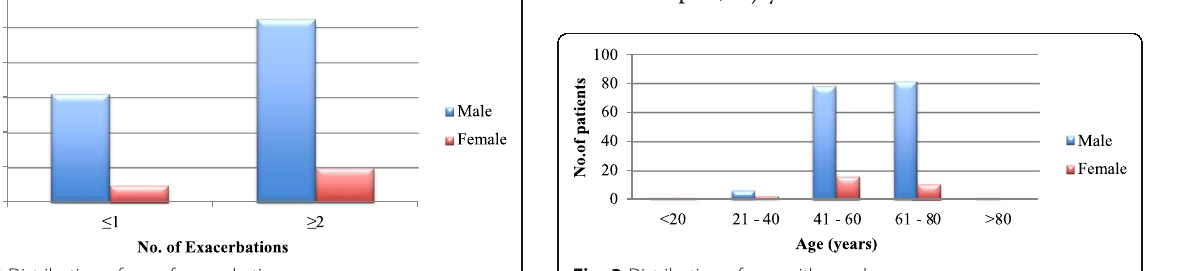
Fig. 2 Distribution of no. of exacerbations